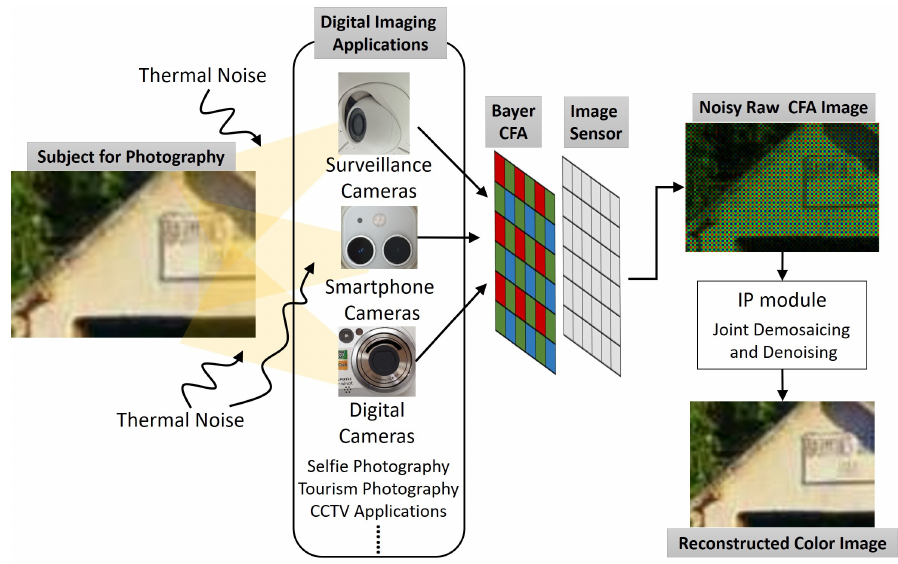
Figure 1. Acquisition system of digital cameras in digital imaging applications. CFA—color filter array, IP—image